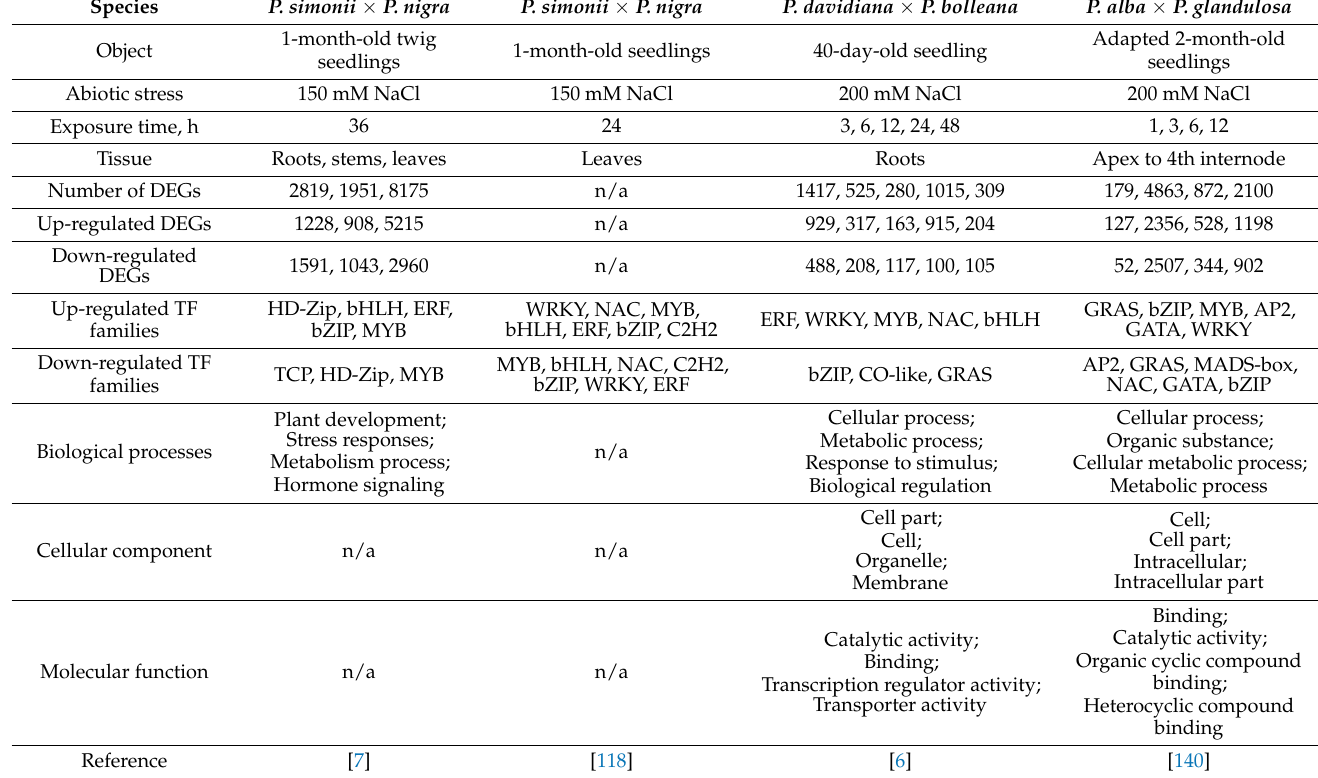
Table 3. The initial conditions and main results of differential expression analysis for poplar hybrids Populus spp. under salt